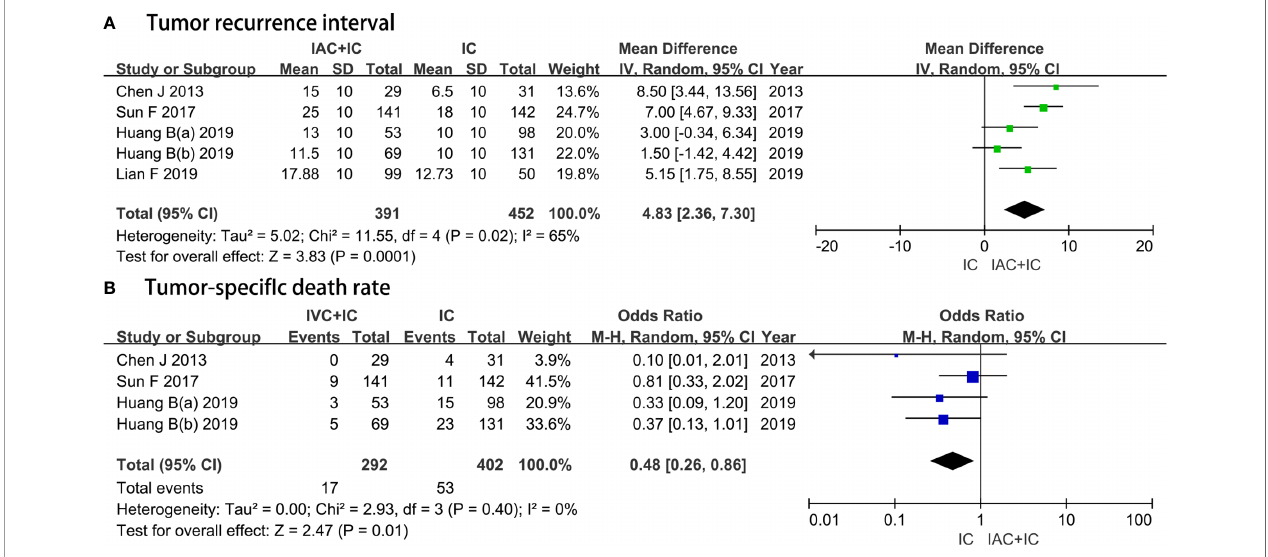
TSDR Four studies with a sample of 694 patients evaluated the TSDR. The results of heterogeneity test were P = 0.40 and I 2 = 0%. TSDR between the IAC + IC group and the IC group was 5.8% (17/292) and 13.2% (53/402), respectively. The forest plots identi fi ed that the IAC + IC group had a statistically lower than the IC group in the TSDR (OR 0.48, 95%CI 0.26 to 0.86, P = 0.01) ( Figure 5B ).